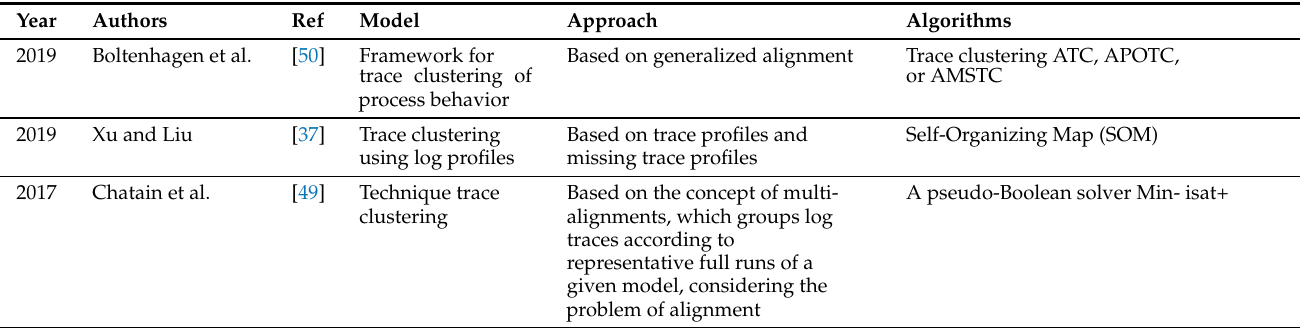
Table 3. Summary of event log preprocessing techniques using the clustering